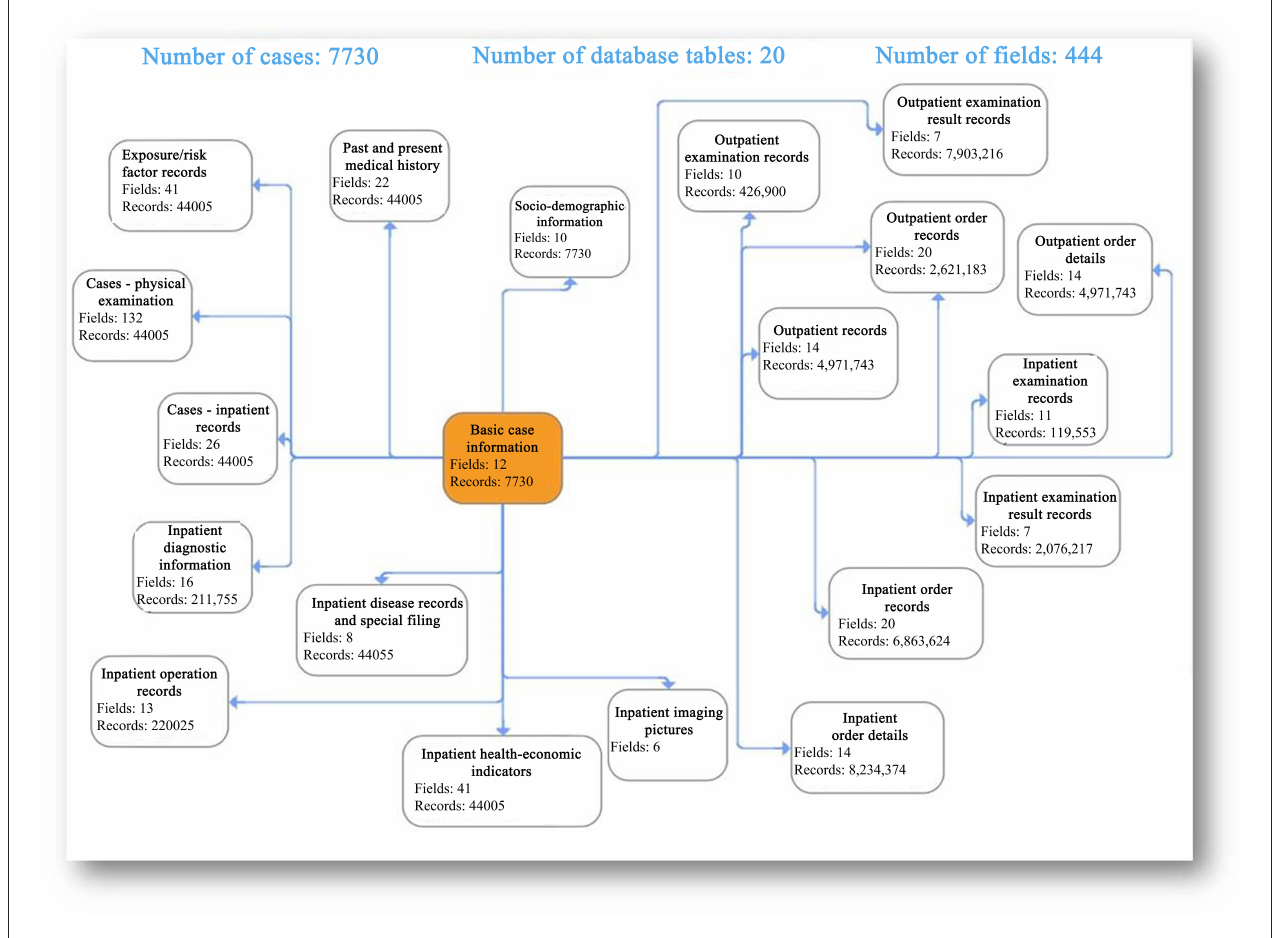
FIGURE 3 | Database cleaning